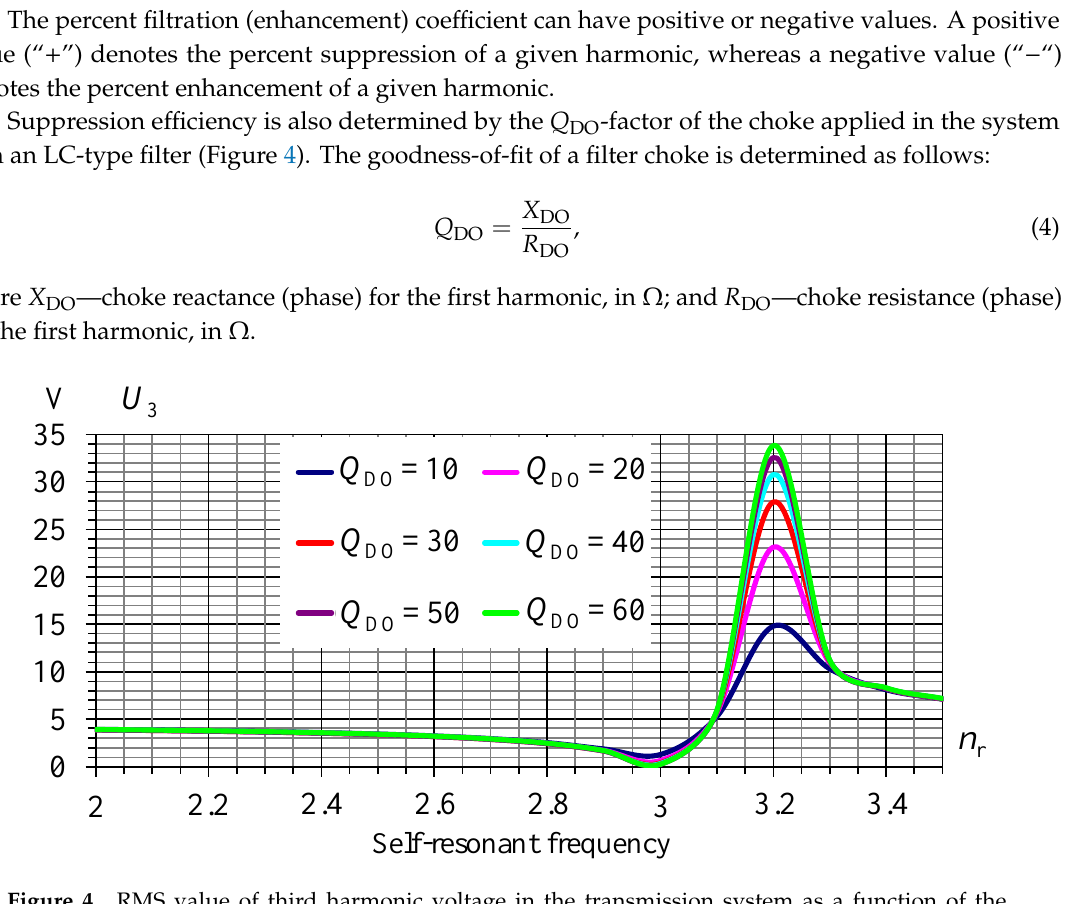
Figure 3. Filtering out higher harmonics as a function of the departure of the self-resonant frequency from the order of the filtered harmonic, subject to the self-resonant frequency of the applied filter ( n - n r ).